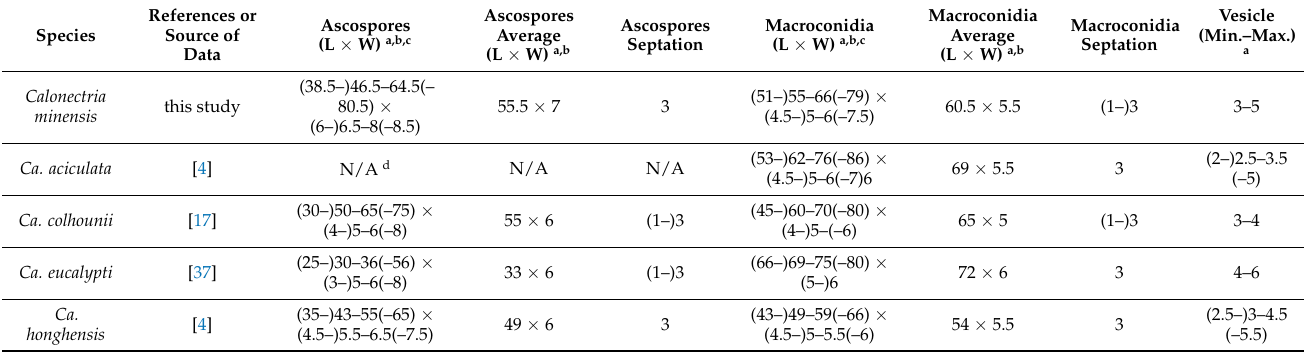
Table 5. Morphological comparisons of Calonectria species obtained in this study and other phyloge- netically closely related